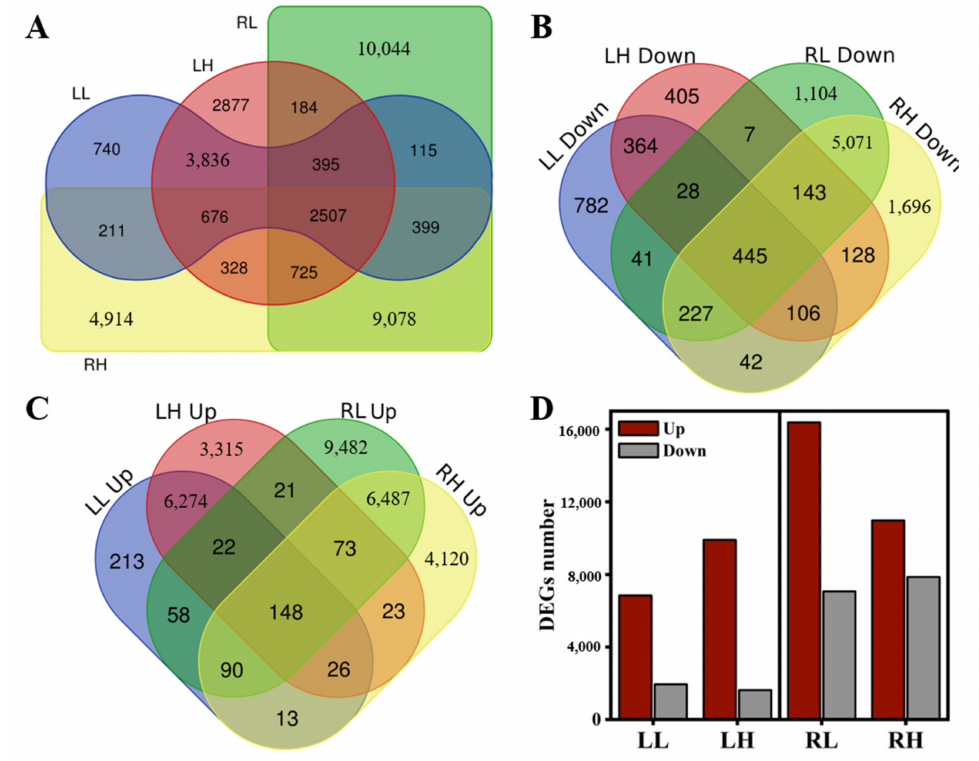
Figure 3. Differentially expressed genes (DEGs) among different groups in Myriophyllum aquaticum . Venn diagram of all DEGs, down-regulated and up-regulated genes, respectively ( A – C ); Total number of up-regulated and down-regulated DEGs ( D ). LL and RL, leaf and root from low phosphorus concentration treatment; LH and RH, leaf and root from high phosphorus concentration